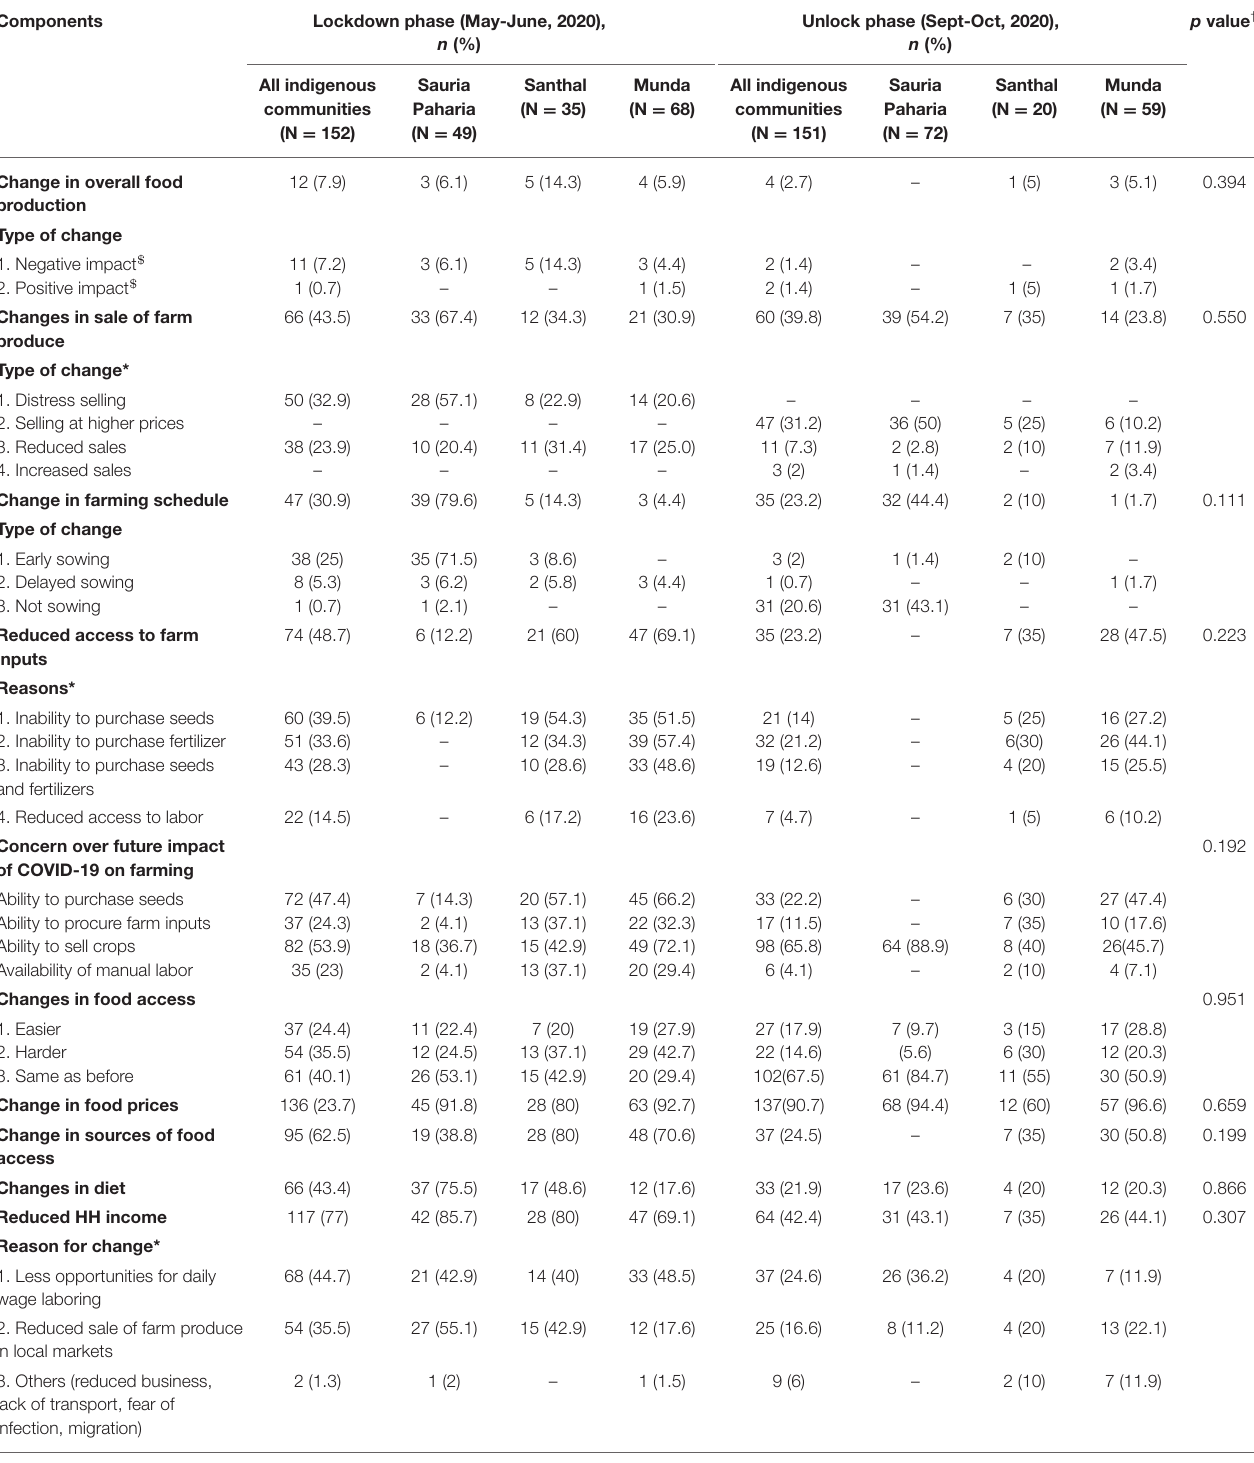
TABLE 2 | Perceived impacts of COVID-19 pandemic on food production and access among indigenous communities of Jharkhand, India.